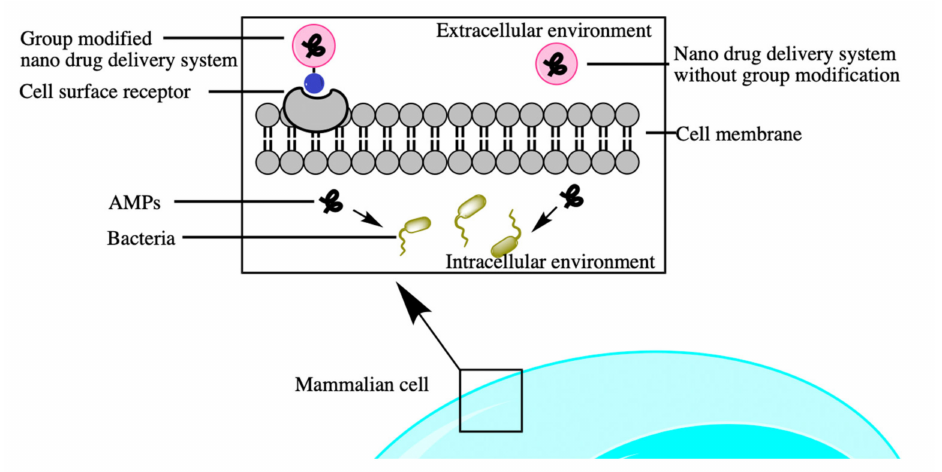
Figure 10. Two systems of delivering AMPs to infected